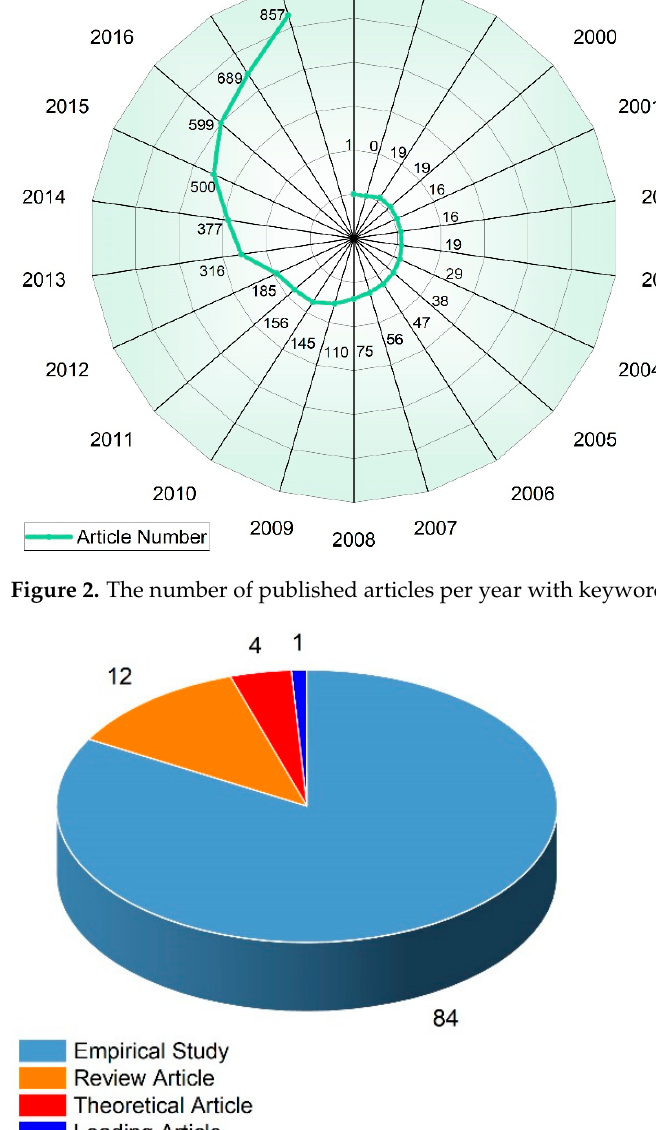
Figure 3. Composition of the sample articles. The numbers in the figure indicate the article number in each category.